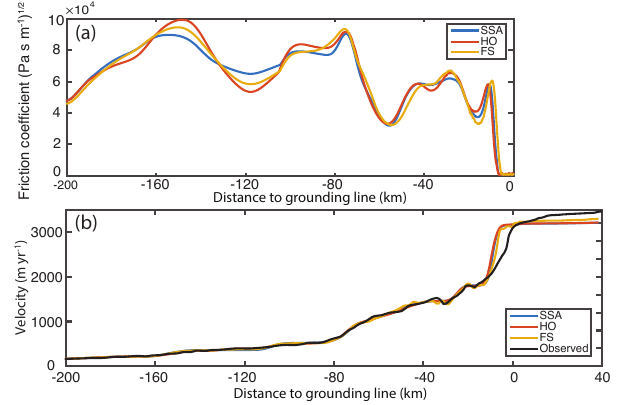
Figure 6. Inversion results of basal friction on flow line AB. (a) Friction coefficient inferred with all three models (FS, HO and SSA). (b) Comparison of modeled surface velocity and observed surface velocity for all three